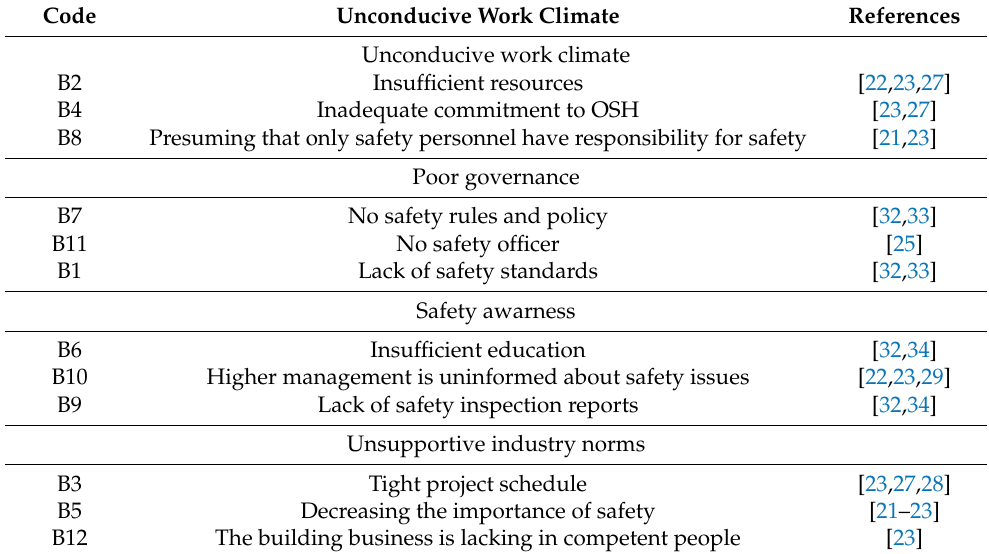
Table 1. Implementation of the safety program: